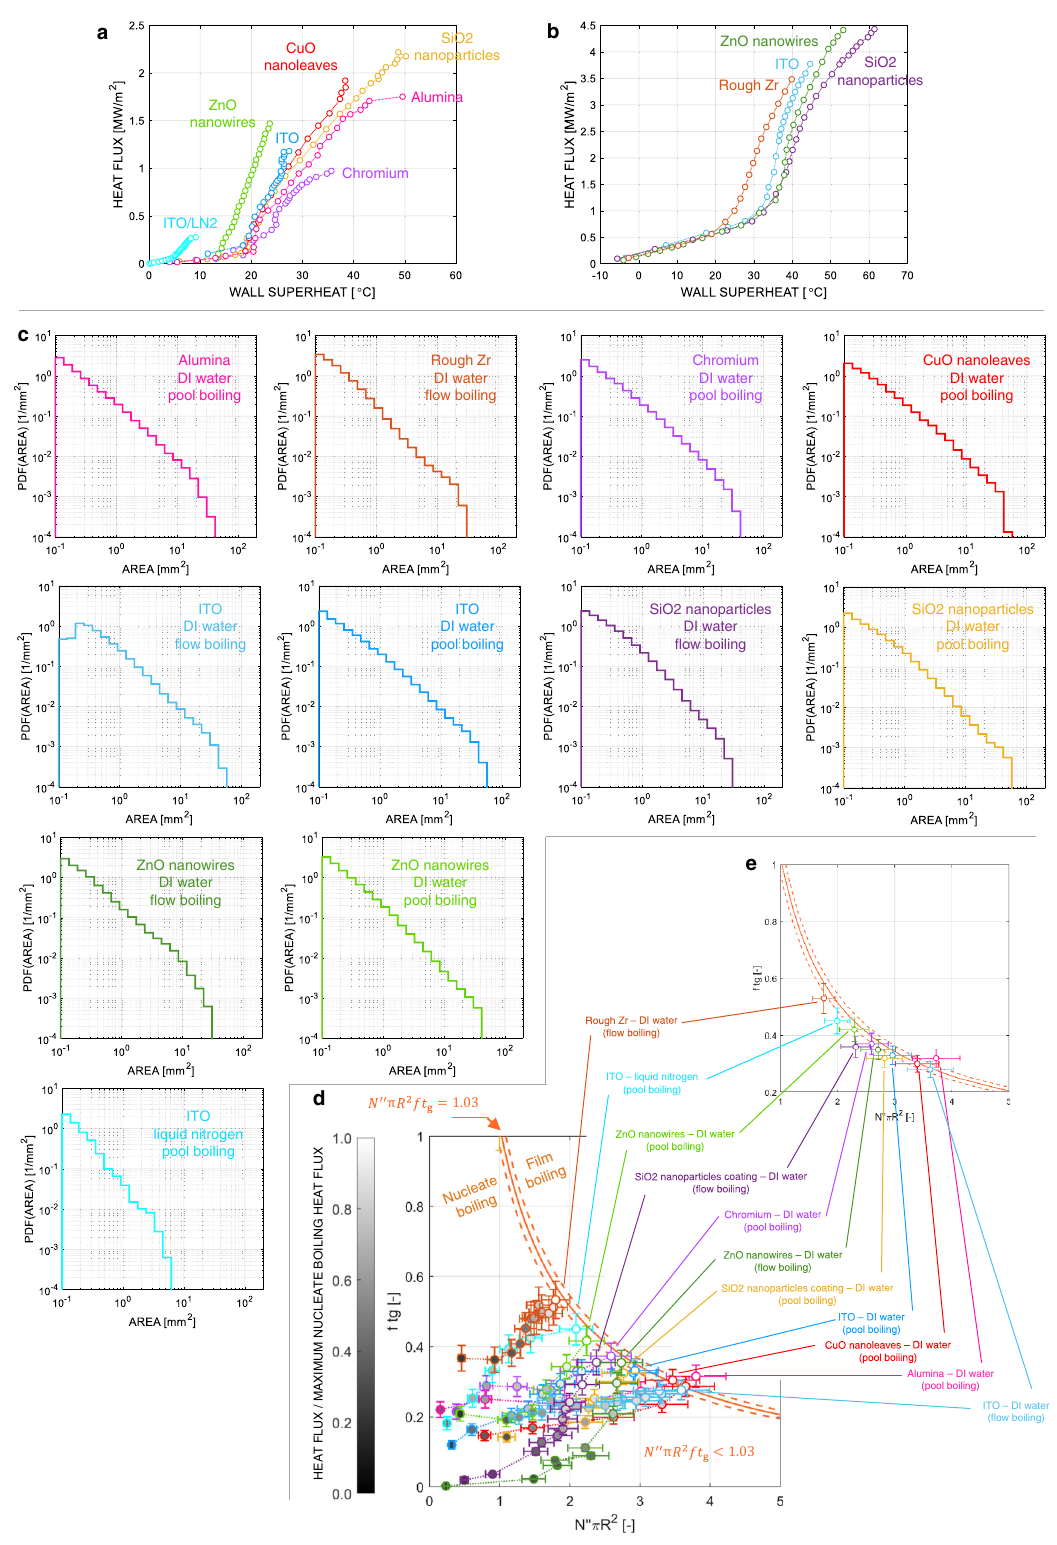
axes are non-dimensional). Figure 7d reports all the boiling points (i.e., it is the equivalent of Fig. 3b), with error bars. Figure 7e only reports the points at the boiling crisis (i.e., it is equivalent to Fig.